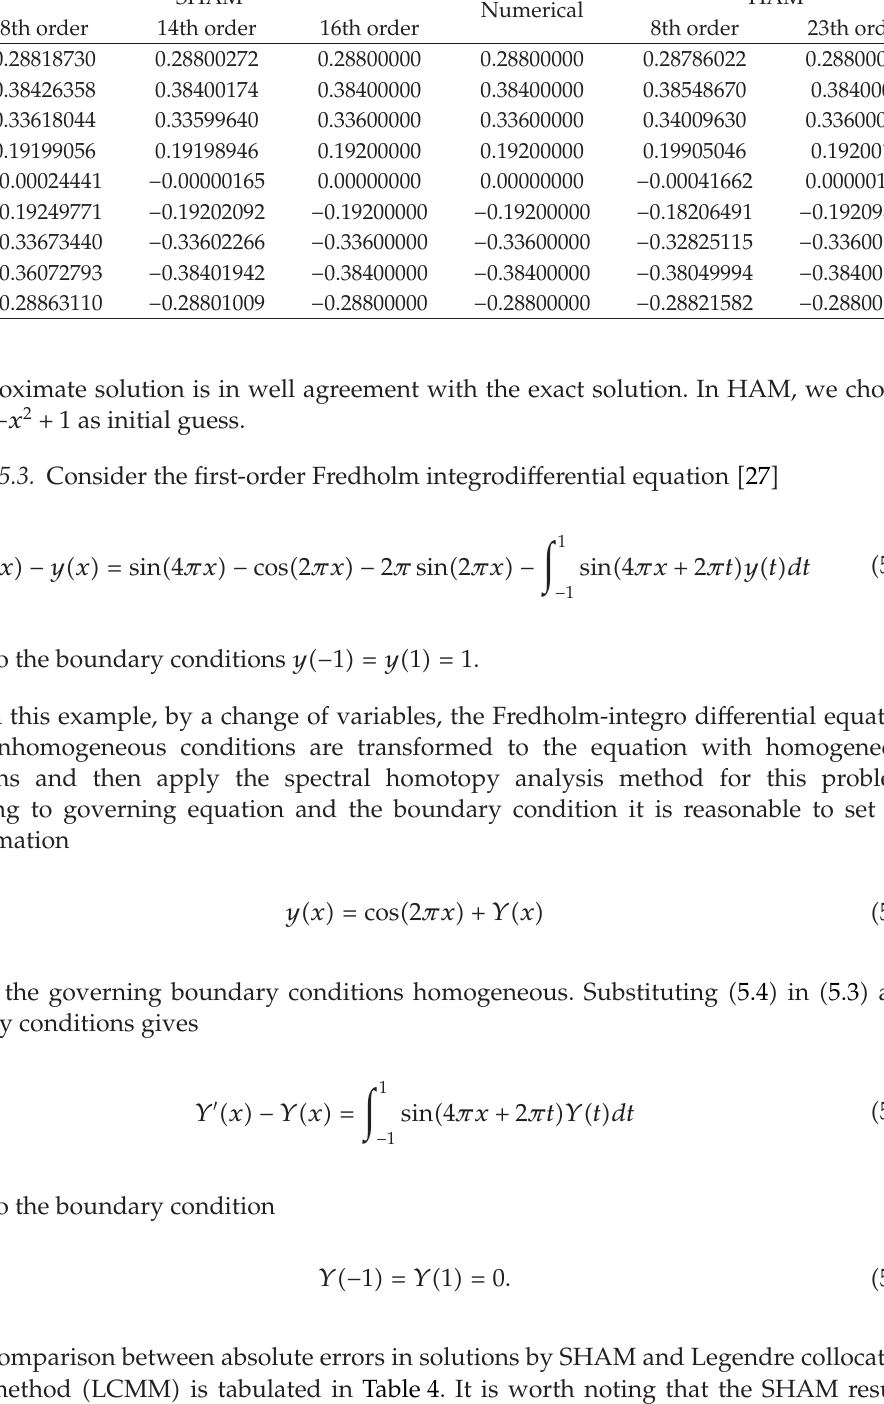
Table 3: Numerical result of Example 5.2 against the HAM and the SHAM solutions whit h (cid:8) − 0 . 4.